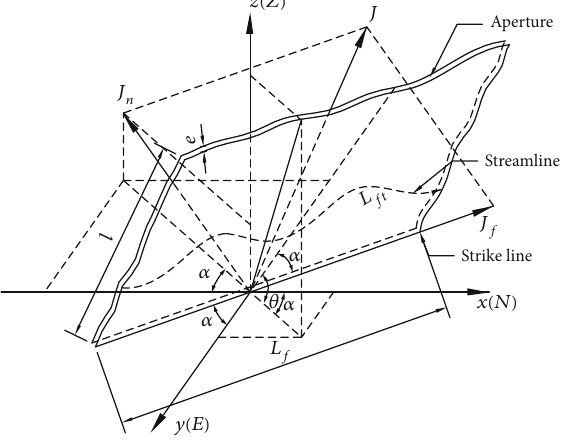
Figure 1: Three-dimensional fracture seepage